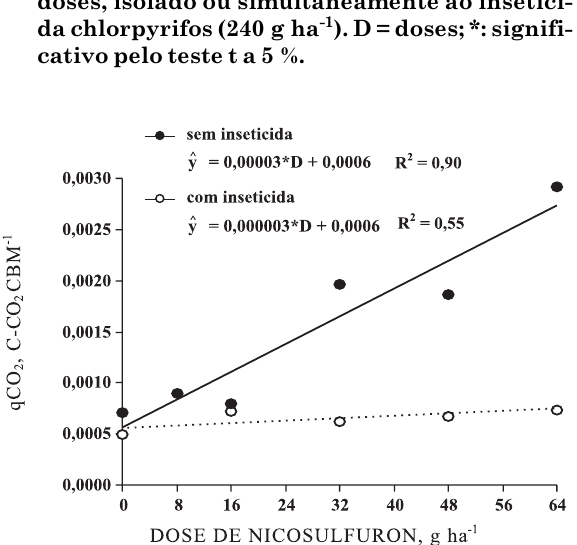
Figura 2. Atividade respiratória basal do solo determinada em amostras de solo, 75 dias após a aplicação de doses do herbicida nicosulfuron, combinadas ou não com o inseticida chlorpyrifos (240 g ha -1 ). D = doses; *: significativo pelo teste t a 5 %.